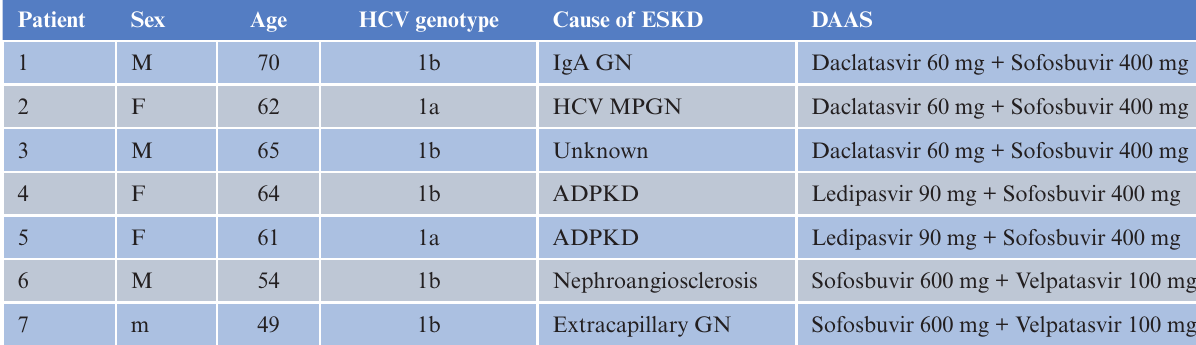
Table 1. Patients